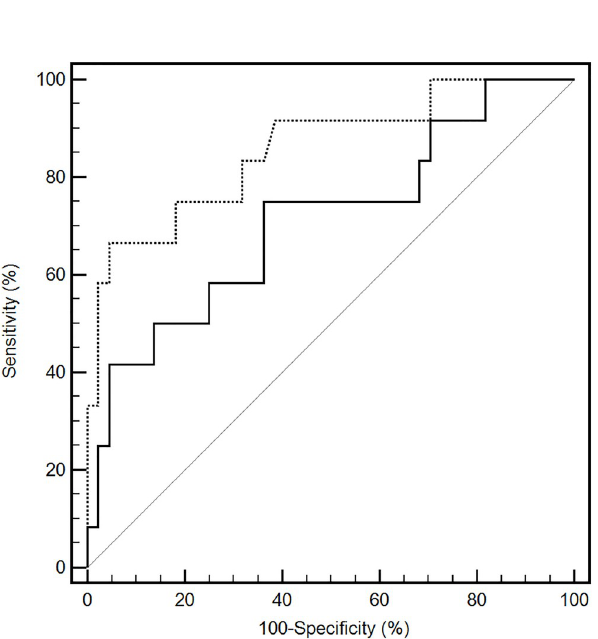
Fig 2. Receiver operating characteristic curves of the HOMA-Adiponectin and HOMA-IR for detecting insulin resistance. The dashed line represents the HOMA-IR (homeostasis model assessment of insulin resistance), and solid line represents the HOMA-Adiponectin (homeostasis model assessment of adiponectin). The solid grey line is the reference and it represents an AUC of